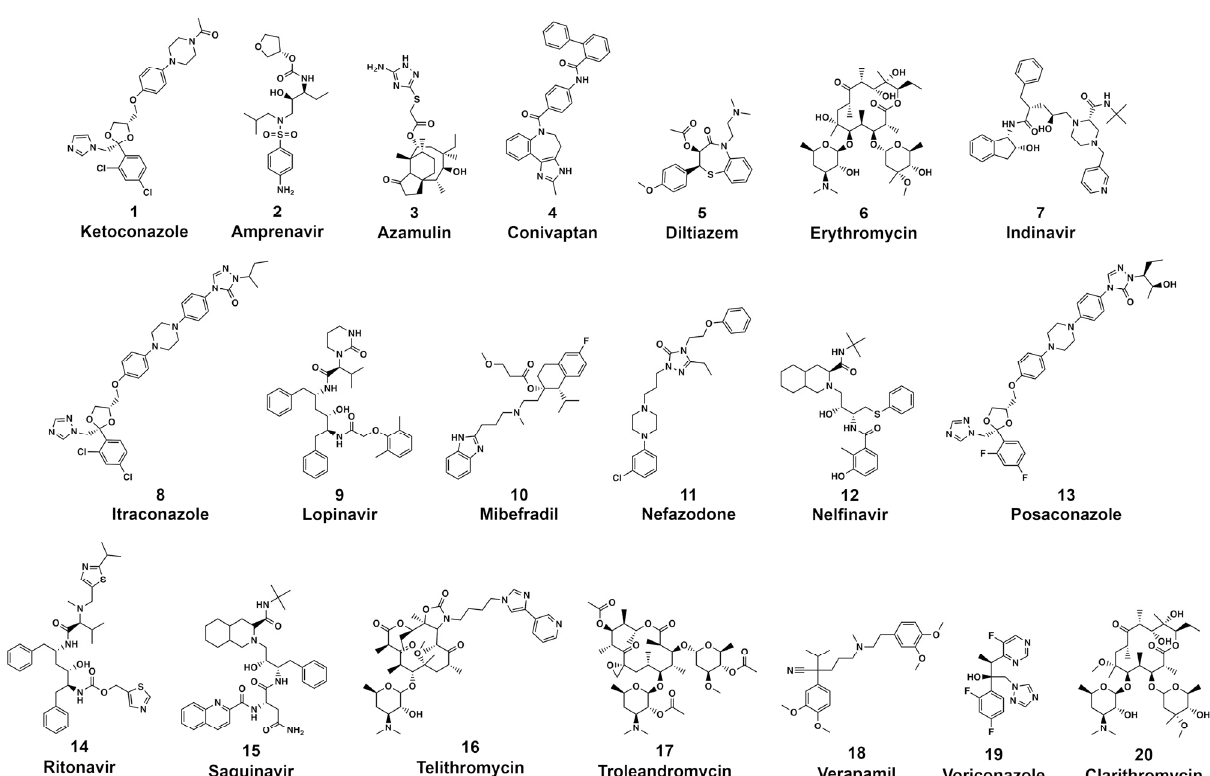
Figure 3. Structures of the 20 most commonly prescribed high-affinity CYP3A4 inhibitors.